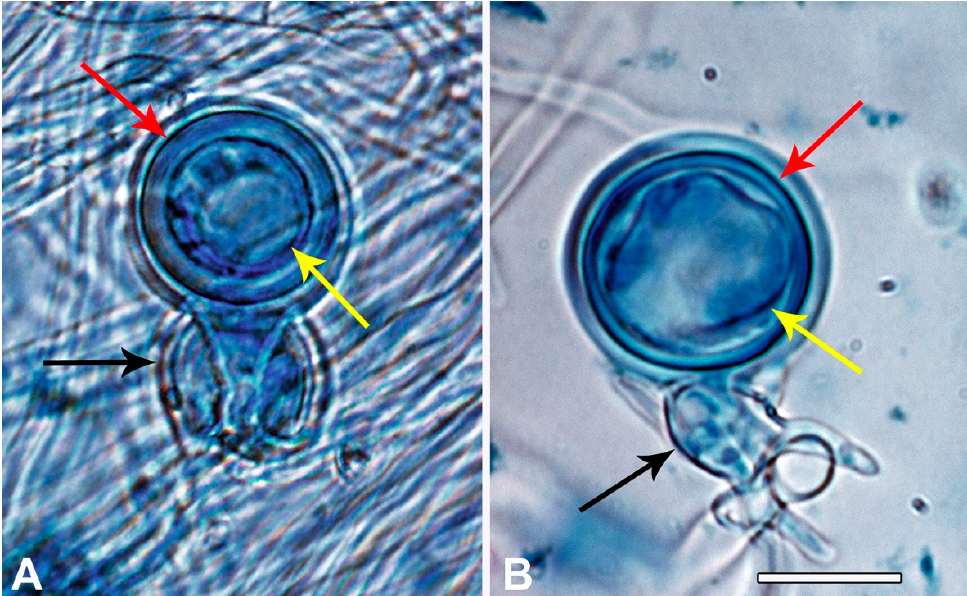
Figure 6. Oogonia from an IC1/A1 × IC2 /A2 pairing (isolates VN160 × VN314) with amphigynous antheridia (black arrows); structures stained with lactophenol blue. ( A ) Oogonium containing a viable oospore with a thick well-developed wall (red arrow), an oily granular matrix and a globose lipid vacuole (yellow arrow). ( B ) Oogonium containing an aborted oospore with a thin irregular wall (red arrow), a glassy refractive matrix with a disorganised vacuole (yellow arrow). Scale bar = 20 μ m.